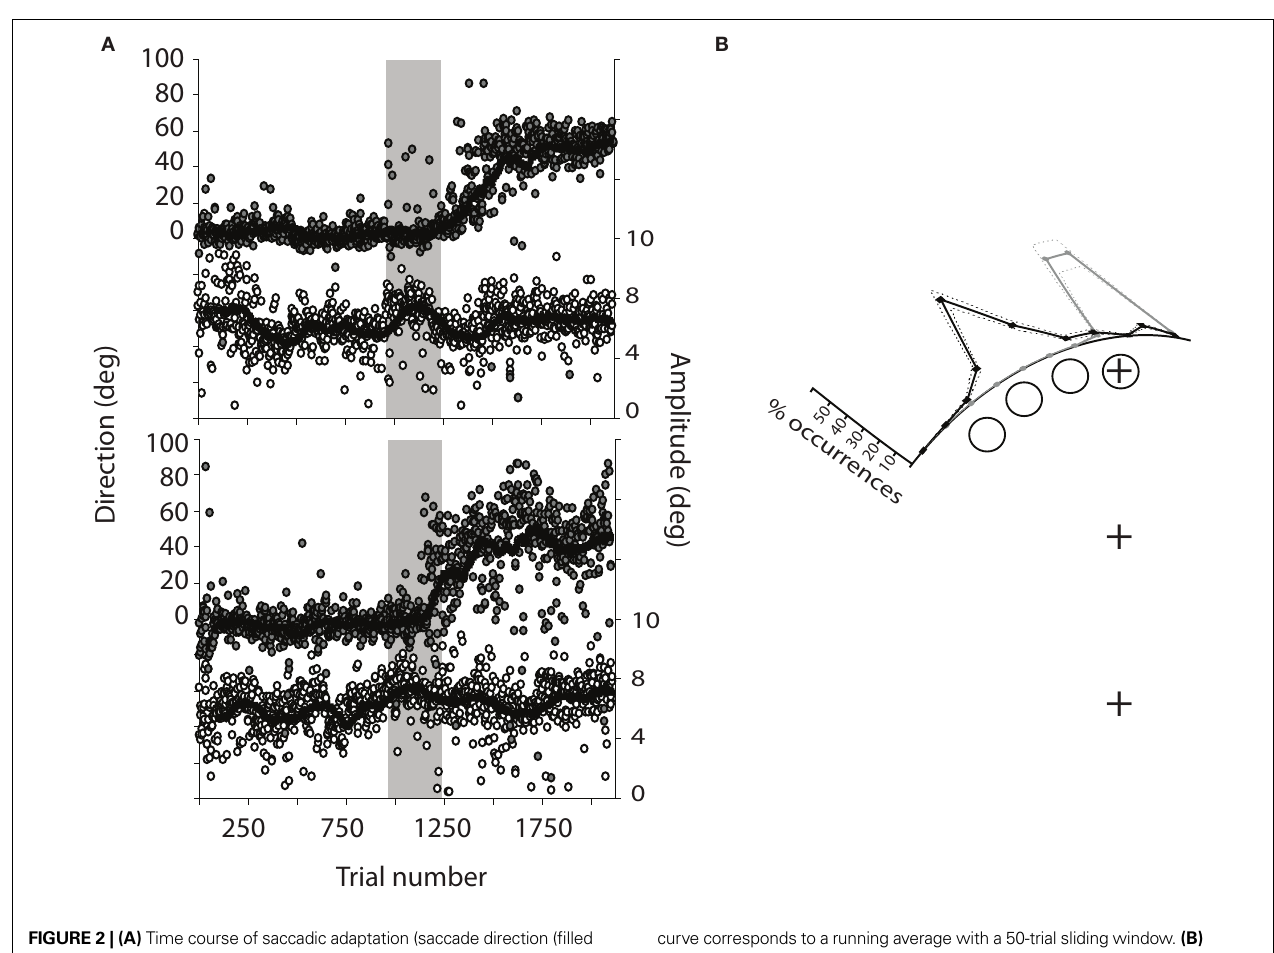
FIGURE 2 | (A) Time course of saccadic adaptation (saccade direction (fi lled symbols) and amplitude (open symbols) as a function of trial number) in two typical participants. The shaded area corresponds to the adaptation phase. Each point corresponds to one saccade and only upward saccades are shown. The